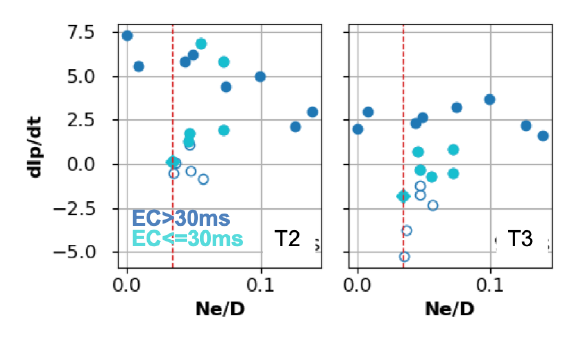
Figure 2. Plasma current development for the present database ( B tor : 2.4 T): (left) after the first 30 ms of EC pulse (T2) and (right) when the control of the ohmic coils takes place (T3). Dark blue bullets correspond to successful burn-through for EC blip longer than 30 ms. Light Blue bullets correspond to successful burn-through when EC pulse is up to 30 ms, empty ones to fail- ures. Vertical dashed line is the limit for ohmic